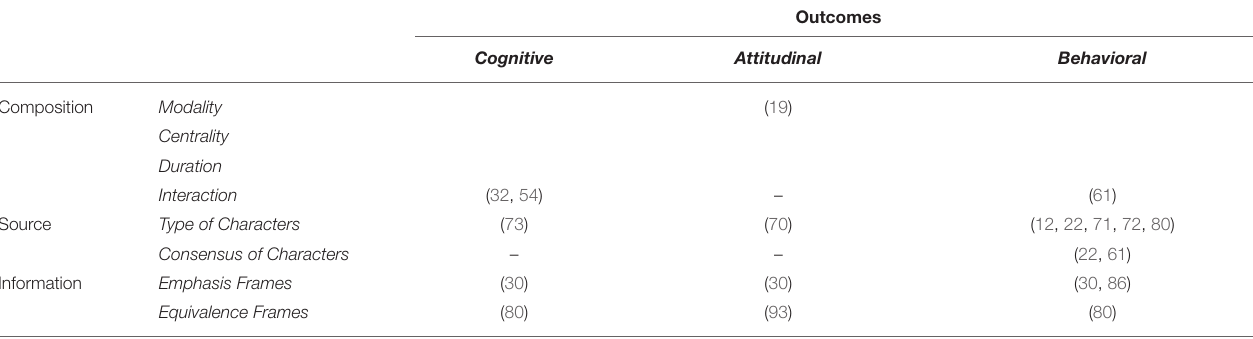
TABLE 1 | Overview of evidence on the persuasive strategies regarding the effects of healthy foods on children.